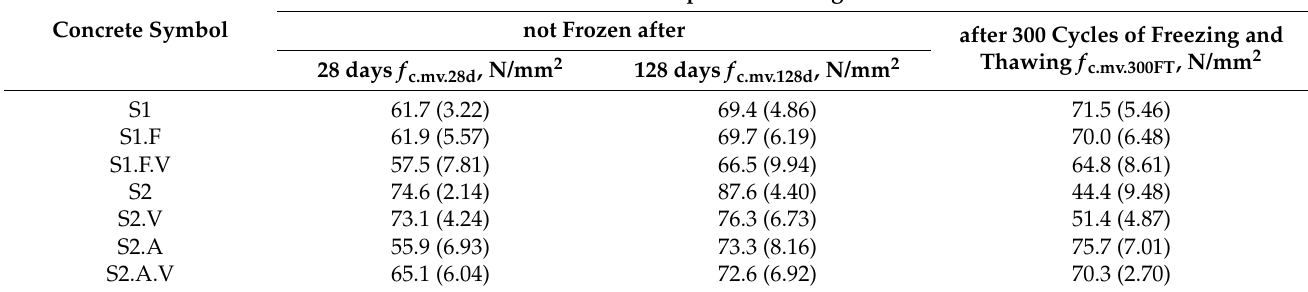
Table 6. Mean compressive strength of non-frozen concrete after 28 and 128 days of curing and concrete after 300 cycles (100 days) of freezing and thawing.